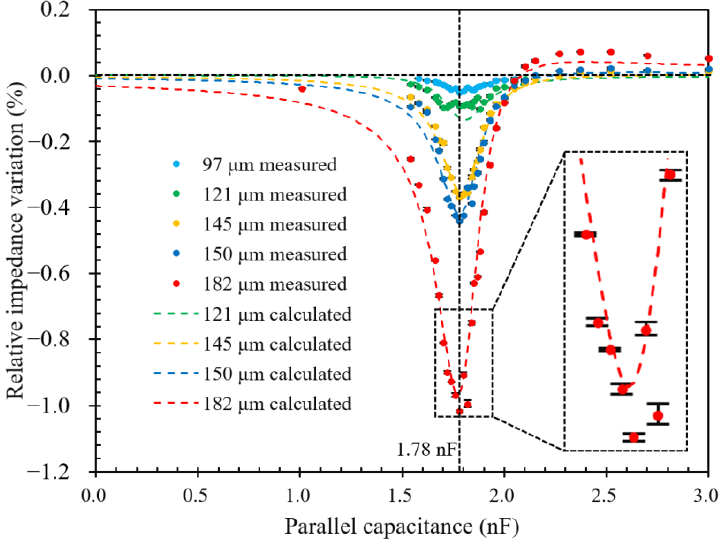
Figure 11. The relative impedance variations induced by five copper particles for different capacitances.